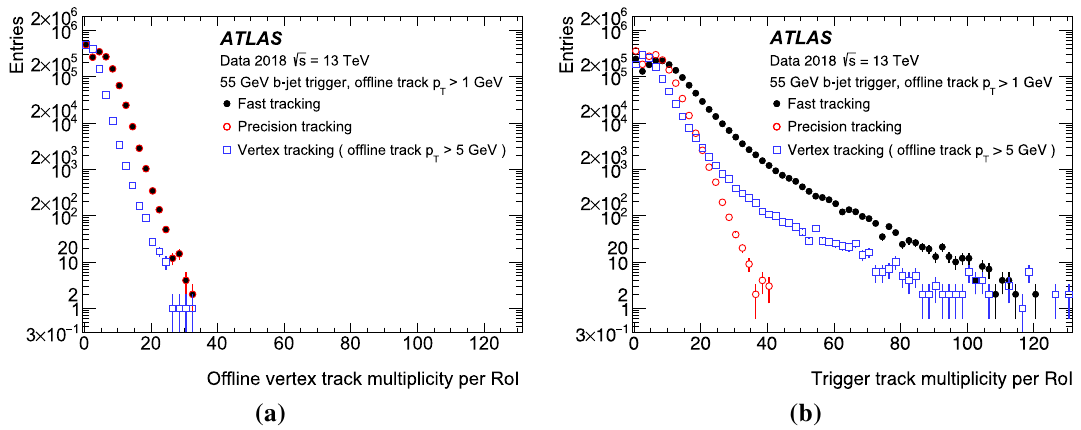
Fig. 37 The multiplicity of tracks found by the offline reconstruction, associated with the primary vertex and contained within the respective b -jet RoI ( a ), and the multiplicity of trigger tracks per RoI ( b )